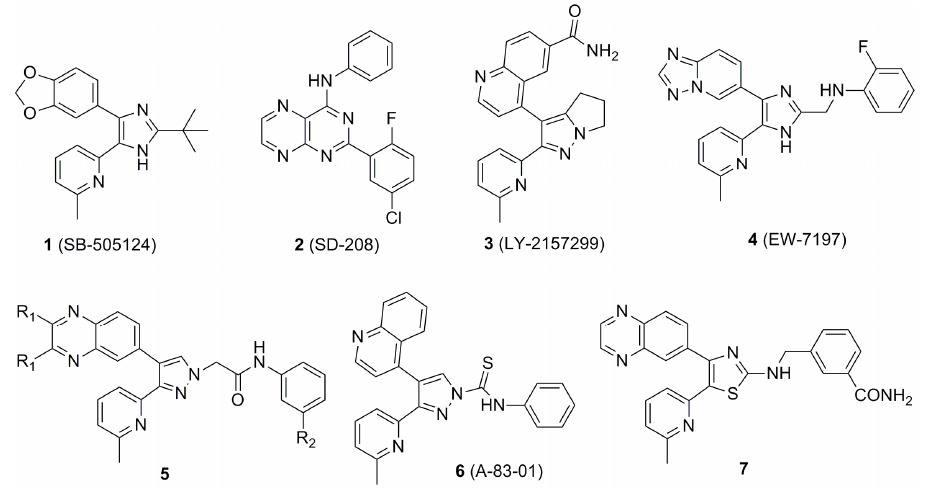
Figure 1. ALK5 inhibitors under development.